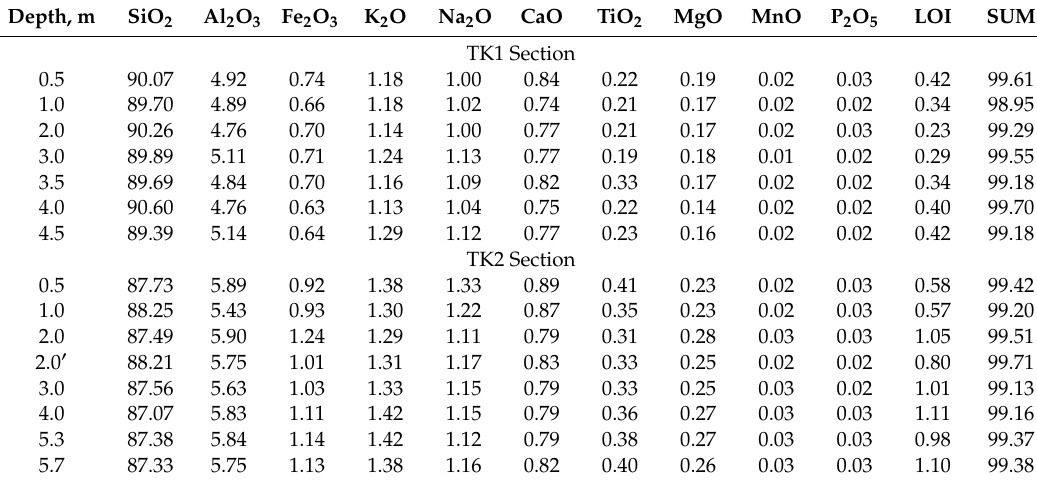
Table 2. Bulk chemical composition (%) of studied sections.